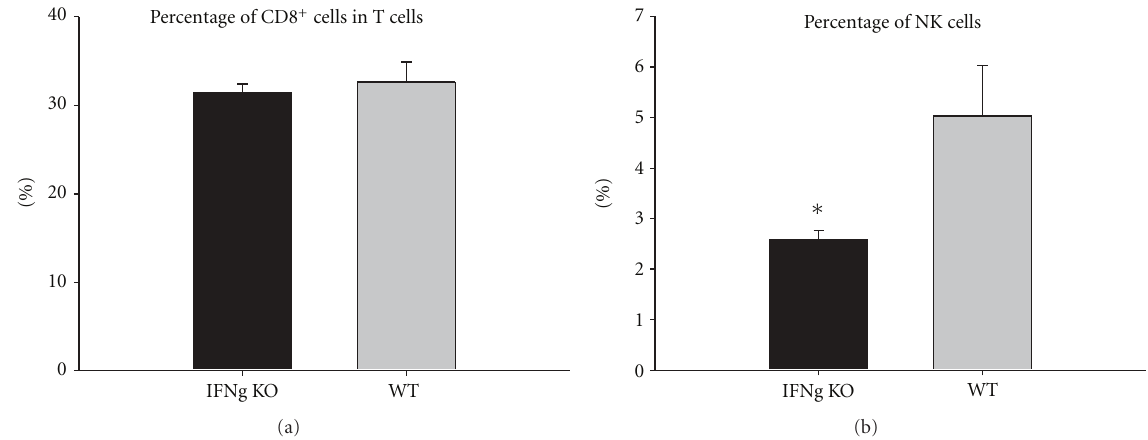
Figure 3: Percentage of CD8 + cells among T cells and NK cells among spleen cells as determined by FACS at 6 weeks after-infection with Schistosoma japonicum (compared with WT mice, ∗ P < 0 .